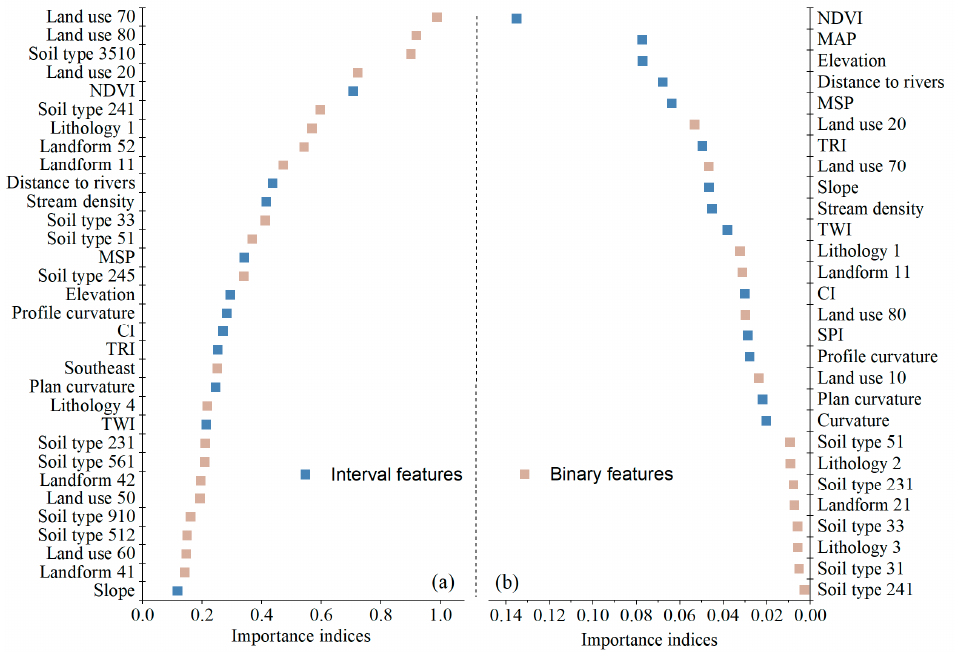
Figure 8. Importance of the selected conditioning factors based on EFS for the LR ( a ) and RF ( b ) models. The names of the conditioning factors are based on the following notation: cultivated land (land use 10); forest (land use 20); wetland (land use 50); water body (land use 60); tundra (land use 70); artificial surface (land use 80); sedimentary rock (lithology 1); intrusive rock (lithology 2); vol- canic rock (lithology 3); melange (lithology 4); dark brown soil (soil type 31); bleaching dark brown soil (soil type 33); whitish soil (soil type 51); black soil (soil type 231); chernozem (soil type